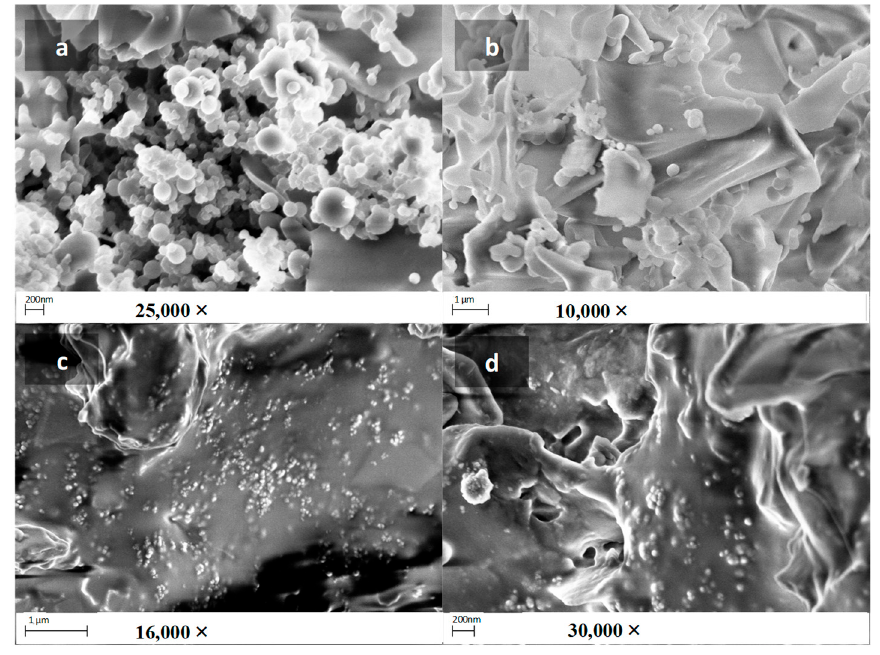
Figure 6. SEM images of crosslinked INVITEMA nanogrids, ( a ) INVITEMA3/30 min; ( b ) INVITEMA3/1 h; ( c ) INVITEMA3/2 h 16,000× and ( d ) INVITEMA3/2 h 30,000×.